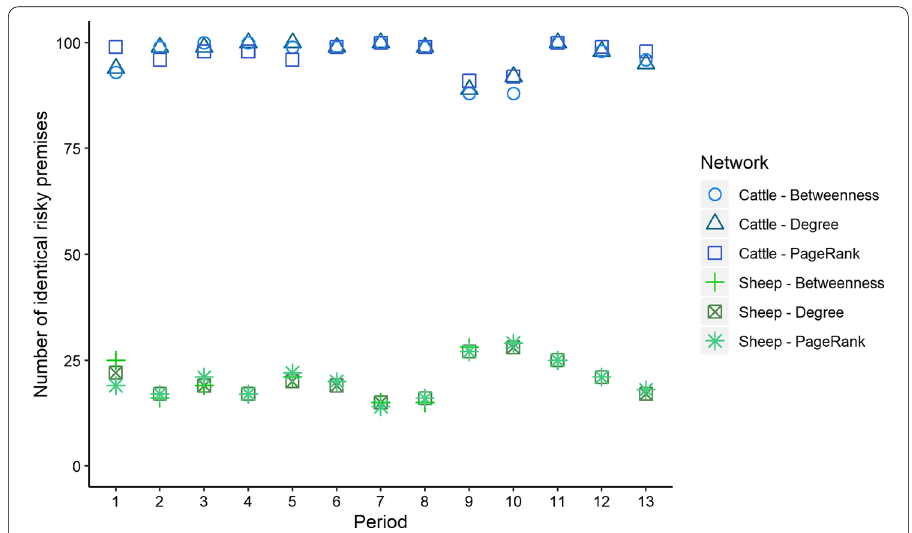
Fig. 6 Comparison of the single‑species and multi‑species static network analysis results. This graph details the variation in the number of identical risky premises between the multi‑species and each of the single‑species networks (cattle in blue, and sheep in green) along the year for the different static network